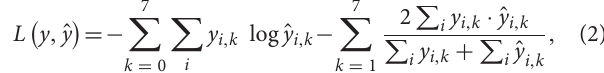
neuroradiologists (C.C. and H.Y.W.) with 11 and 6 years